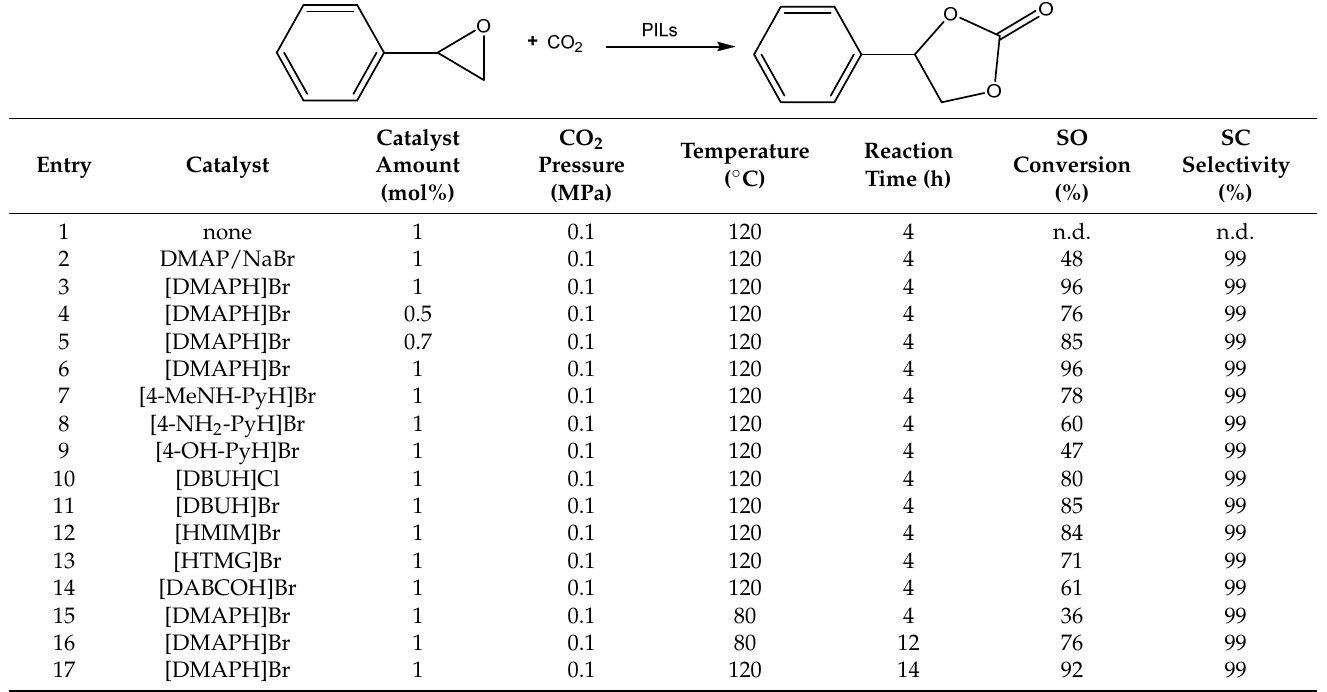
Table 6. Synthesis of SC catalyzed by different PILs [42].